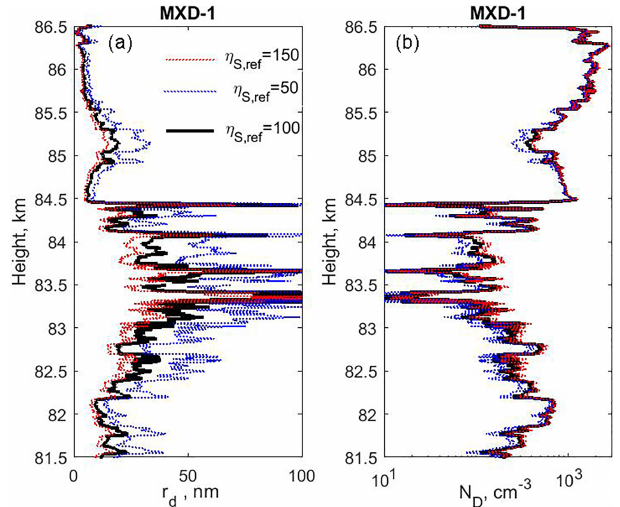
Figure 4. The inferred dust radius r d and dust density N D within the main cloud for the three values of the secondary charge effi- ciency as given in panel (a) . We have applied a moderate sliding mean smoothing over 100 data points, changing the altitude resolu- tion from 0.1m in the observed data points to 10m. We have also removed the signals in the altitude region of 83.5 to 83.55km, which is dominated by strong noise from the squib firing, shown in Figs. 2 and